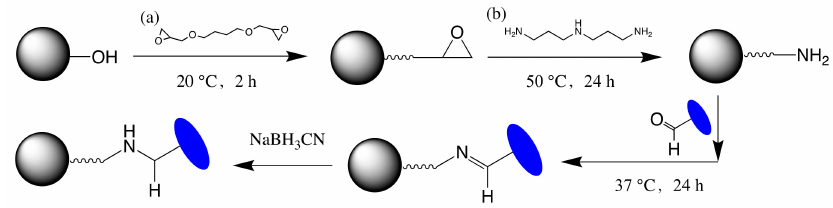
Figure 9. Scheme of the preparation of a VHH based immunoadsorbent: ( a ) 1,4-butanediol diglycidyl and ( b ) 3,3 (cid:48) -diaminodipropylamine were used to prepare the amino-activated matrix based on the